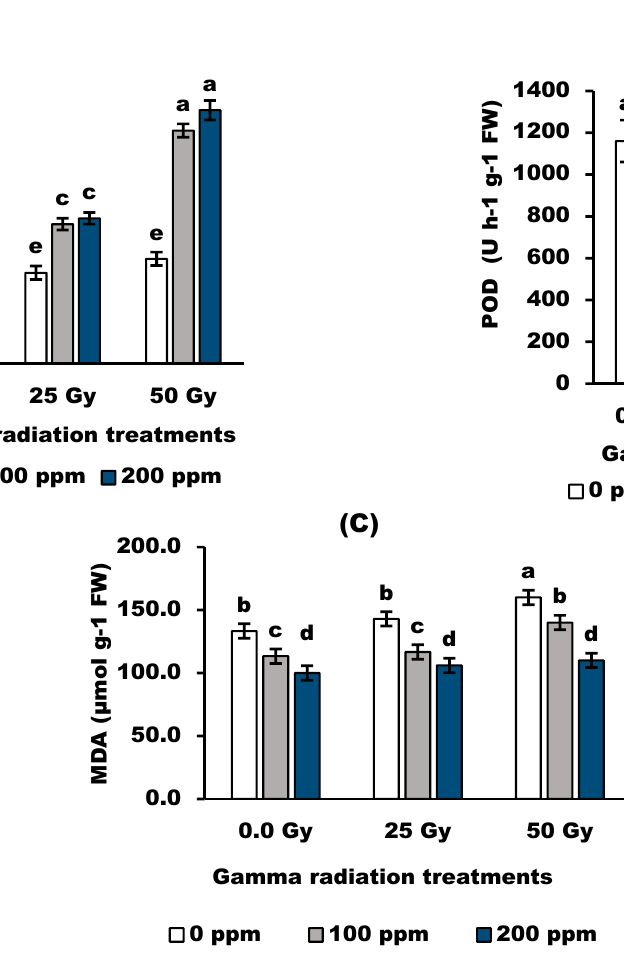
Figure 4. Effect of stigmasterol treatments on the activities of antioxidant enzymes; ( A ) CAT and ( B ) POD, and ( C ) lipid peroxidation of wheat plants grown from grain irradiated with gamma rays. The different letters (a–f) show statistical significance at p < 0.05; vertical bars indicate ±SD.